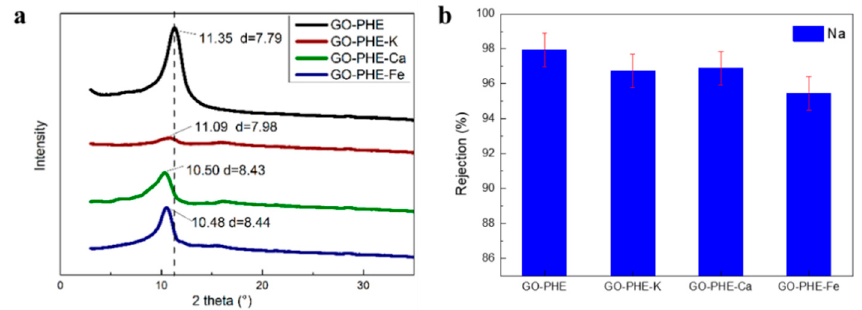
Figure 8. ( a ) XRD spectra of GO-PHE, GO-PHE-K, GO-PHE-Ca and GO-PHE-Fe. ( b ) Rejection coefficient of Na + through GO-PHE, GO-PHE-K, GO-PHE-Ca and GO-PHE-Fe. [NaNO 3 ] = 0.05 mol/L, [HNO 3 ] = 1.0 mol/L. GO-PHE-K, GO-PHE-Ca, and GO-PHE-Fe was GO-PHE membranes